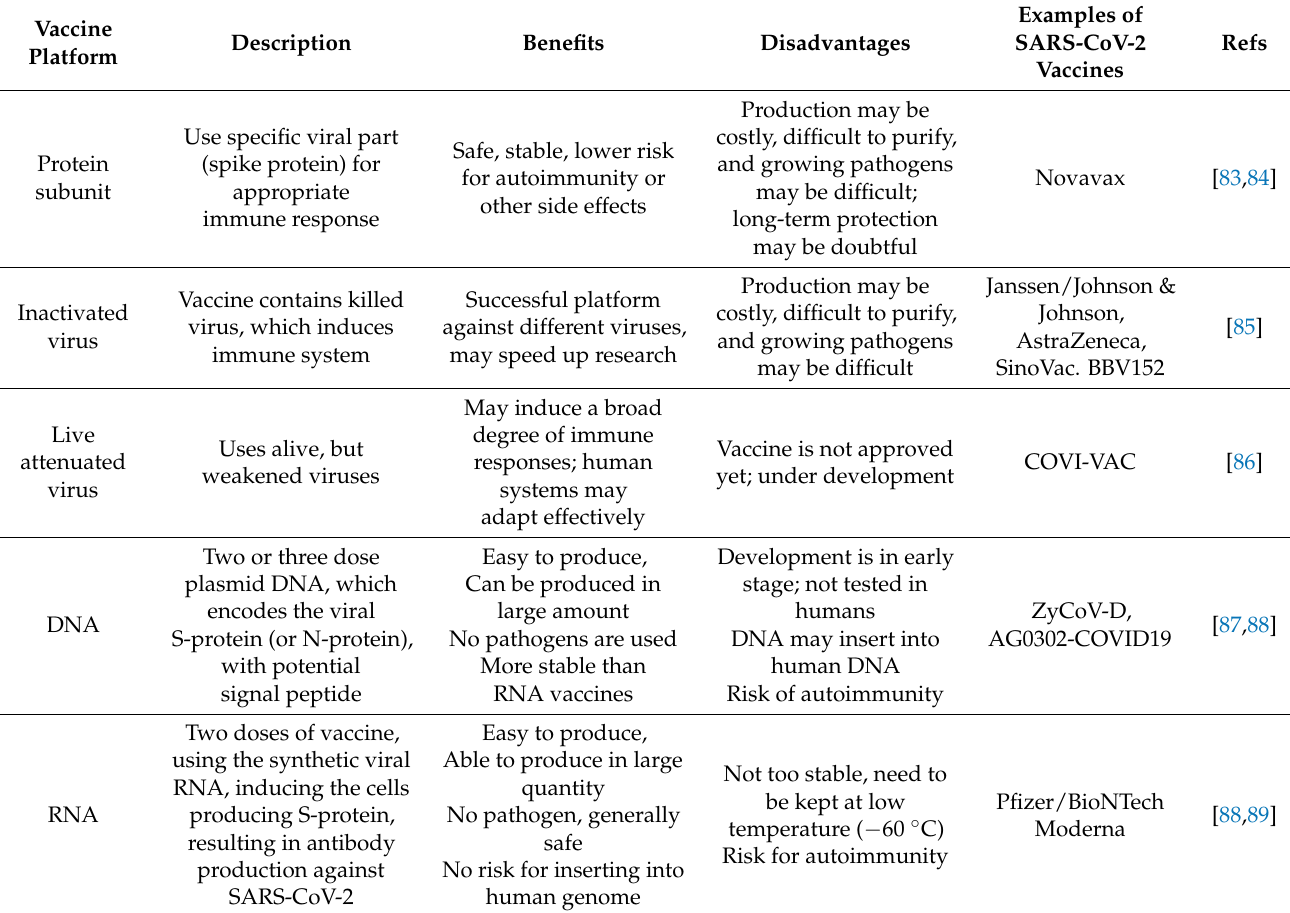
Table 2. SARS-CoV-2 vaccine